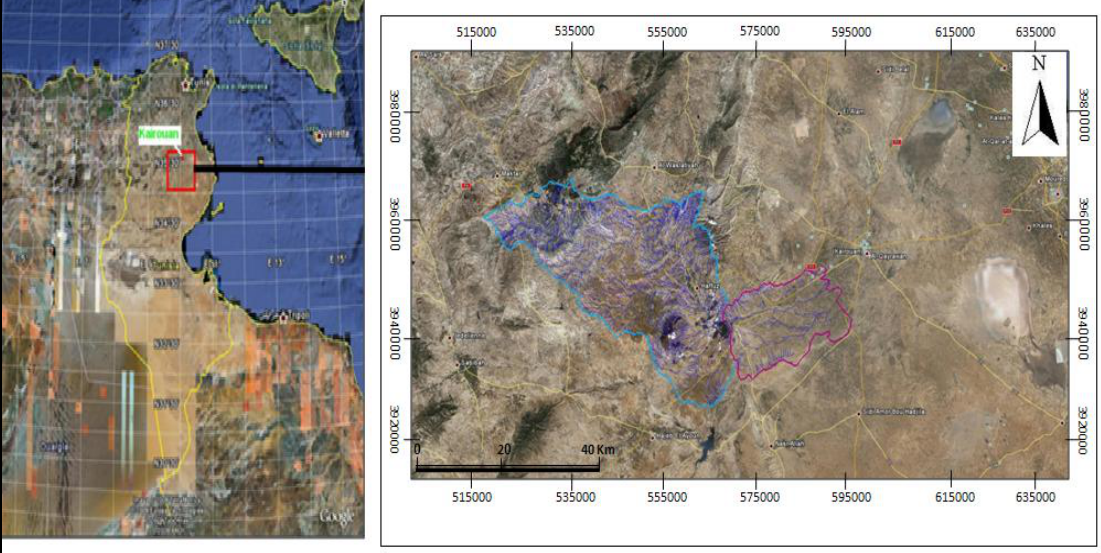
Figure 1. Location of the studied site and land-cover map during the 2009–2010 vegetation